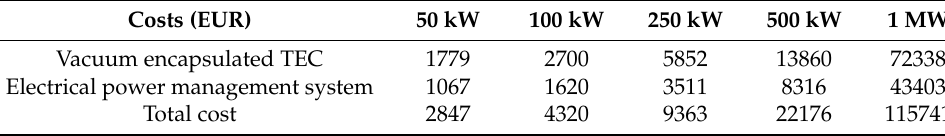
Table A5. Calculation of the costs for the complete TEC system